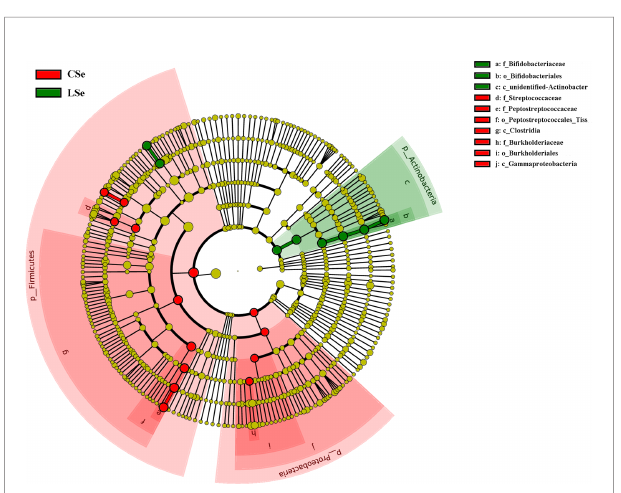
FIGURE 7 | LefSe analysis of bacterial community structure in small intestinal contents of mice.